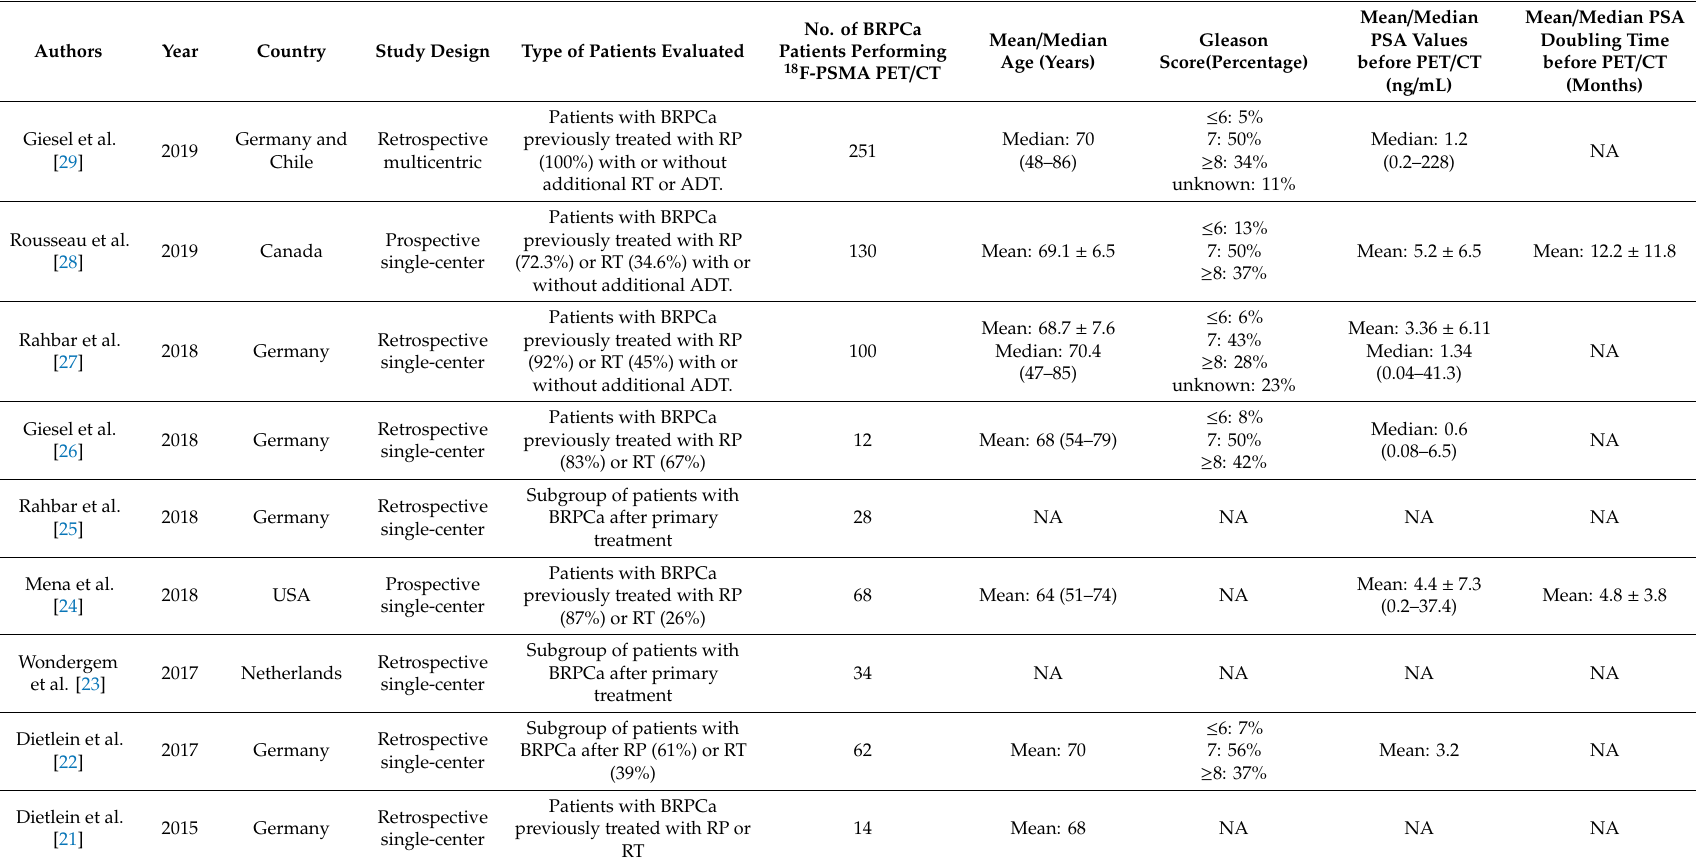
Table 1. Basic study and patient